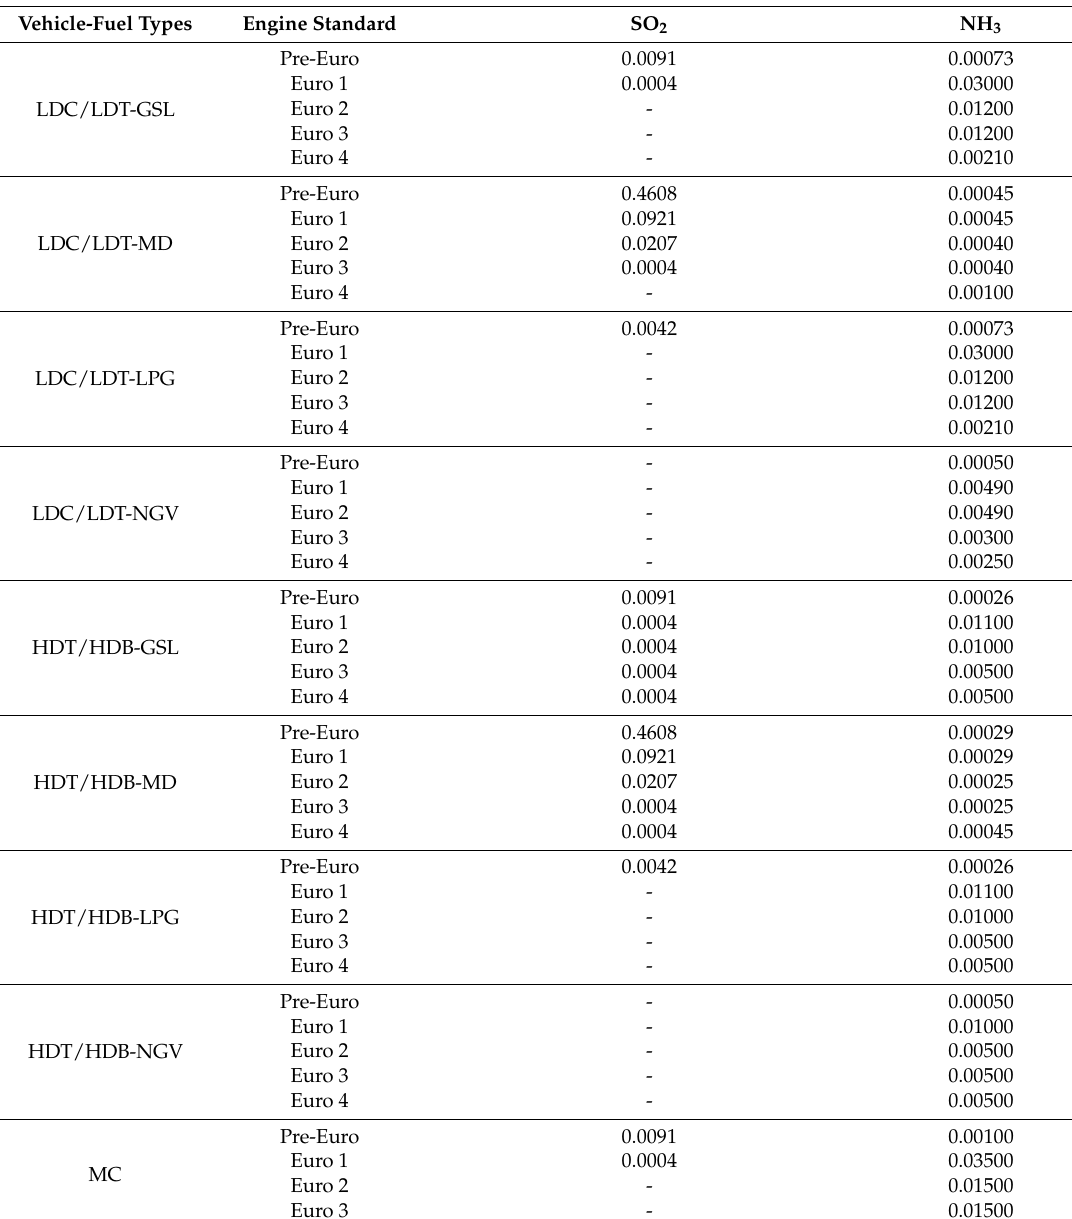
(c) Emission Factor of Acidic Substance (Unit: kt